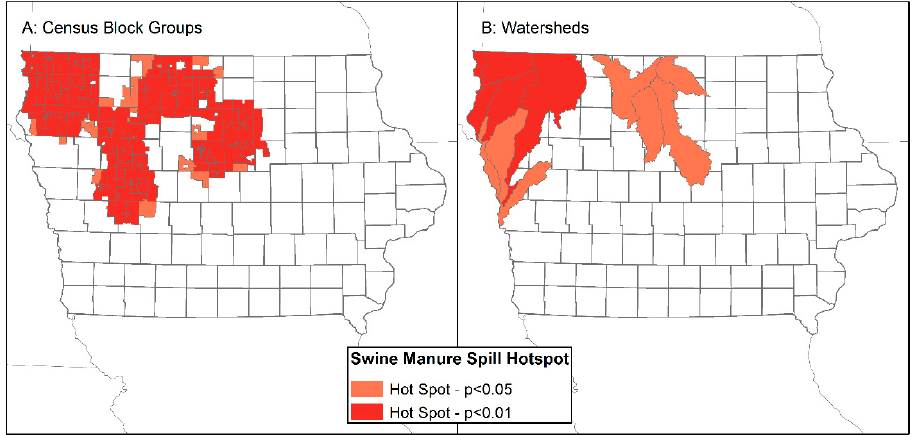
Figure 5. Hotspots of high swine manure spill density in Census block groups ( A ) and watersheds ( B ).